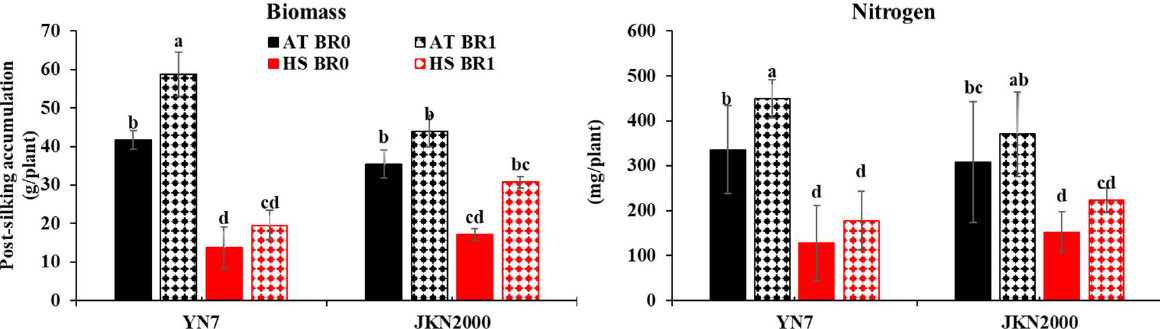
Figure 2. Effects of foliar BR application at the silking stage on post-silking biomass and nitrogen accumulation of fresh waxy maize under post-silking ambient and high temperatures. AT, ambient temperature; HS, heat stress; BR0, application of water; BR1, application of 0.25 mg/L BR. The different letters on the column mean the difference was significant at the p < 0.05 level.